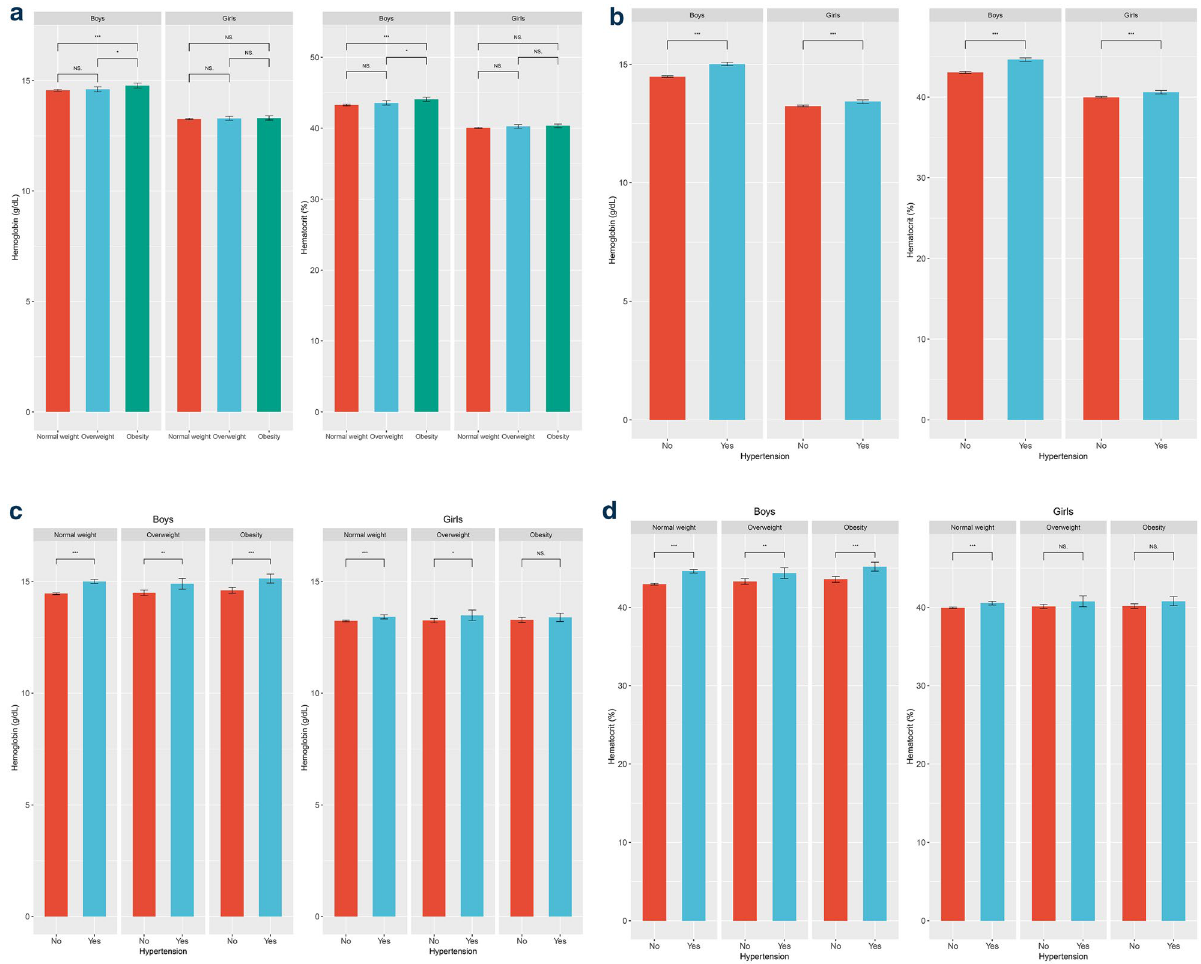
*** p < 0.001. ( c ). Hemoglobin count according to BMI group, and hypertension status in boys and girls. * p < 0.05, ** p < 0.005, *** p < 0.001, NS, p > 0.05. ( d ). Hematocrit according to BMI group, and hypertension status in